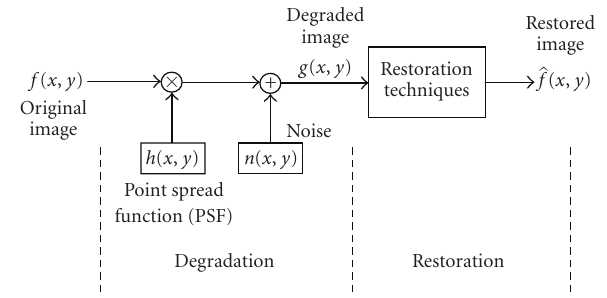
Figure 1: General process for image